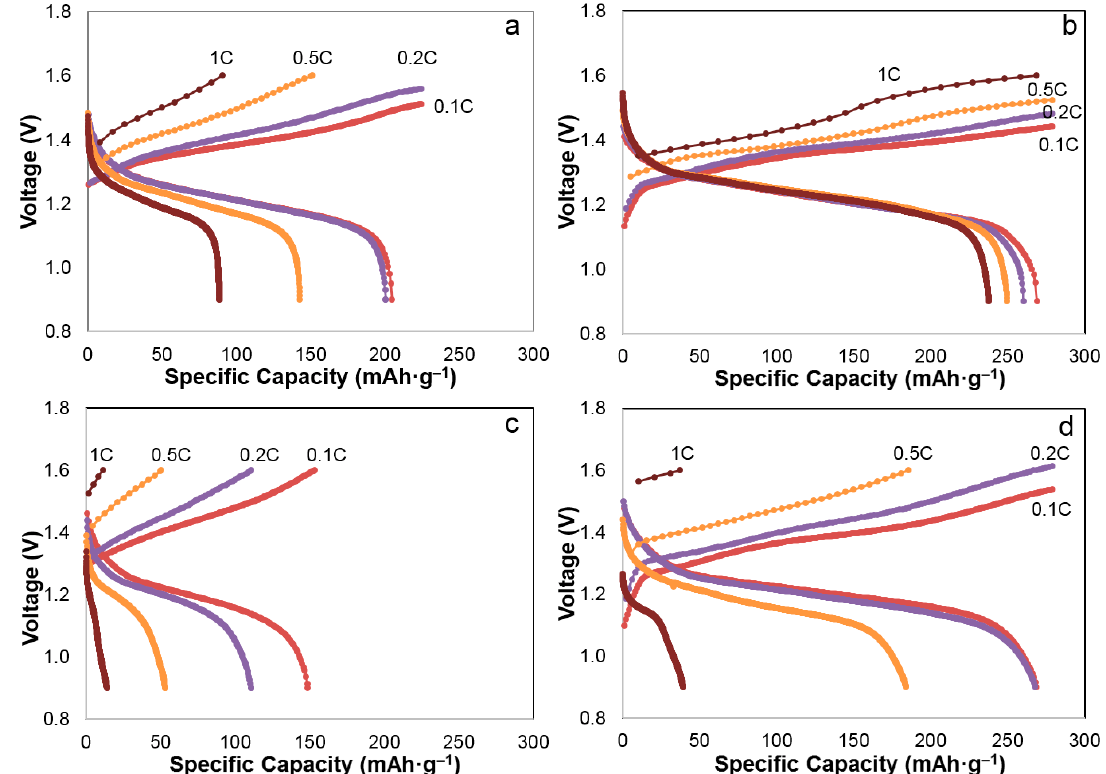
Figure 5. Charge rate evaluation by measuring both the charge and discharge capacities of ( a ) Cell AP50 and ( b ) Cell WM12 at room temperature and ( c ) Cell AP50 and ( d ) Cell WM12 at − 10 °C. All measurements were discharged at 0.1C. Table 4. Charge and discharge capacities obtained with different charge rates for Cells AP50 and WM12 at both room temperature (RT) and − 10 °C.